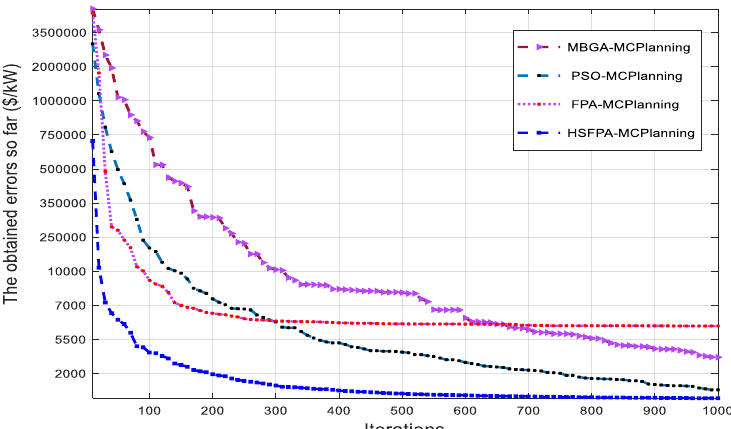
Figure 9. The planned curve results of the schemes of the HSFPA, MBGA, PSO, and AOA methodologies according to the yearly schedule.